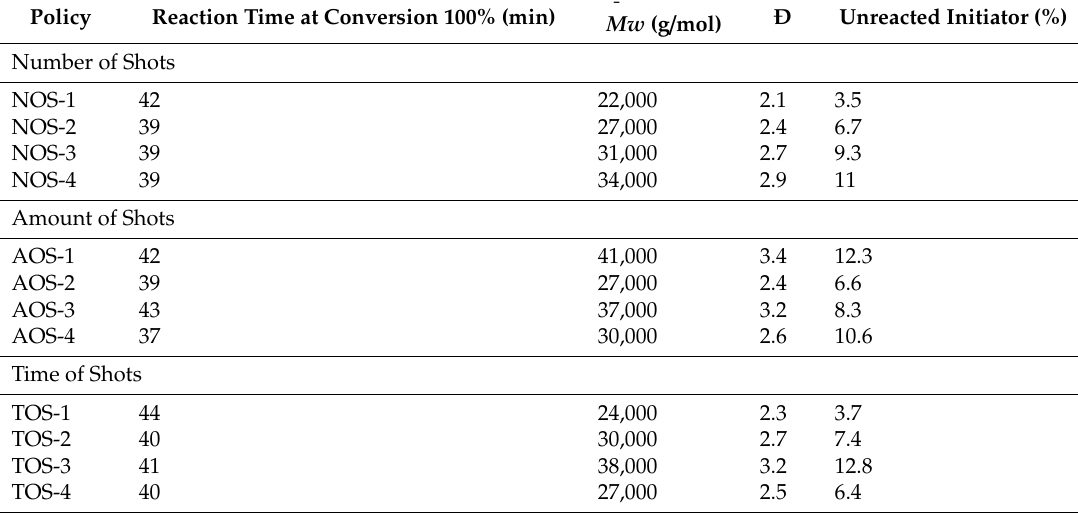
Table 4. Simulated data of free radical polymerization of styrene (Case 2) according to various initiator feeding policies (NOS, AOS, and TOS as per Table 3, with an equal total amount of